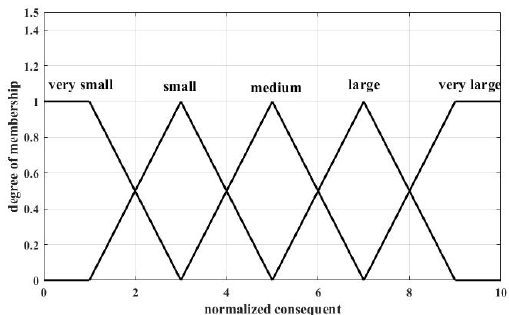
Figure 3. MFs for normalized consequents.